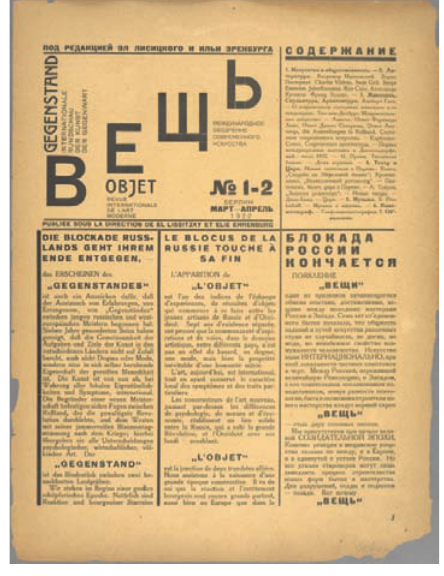
fig. 4 “Vešč’-Gegenstand-Objet”, iii, p. 1